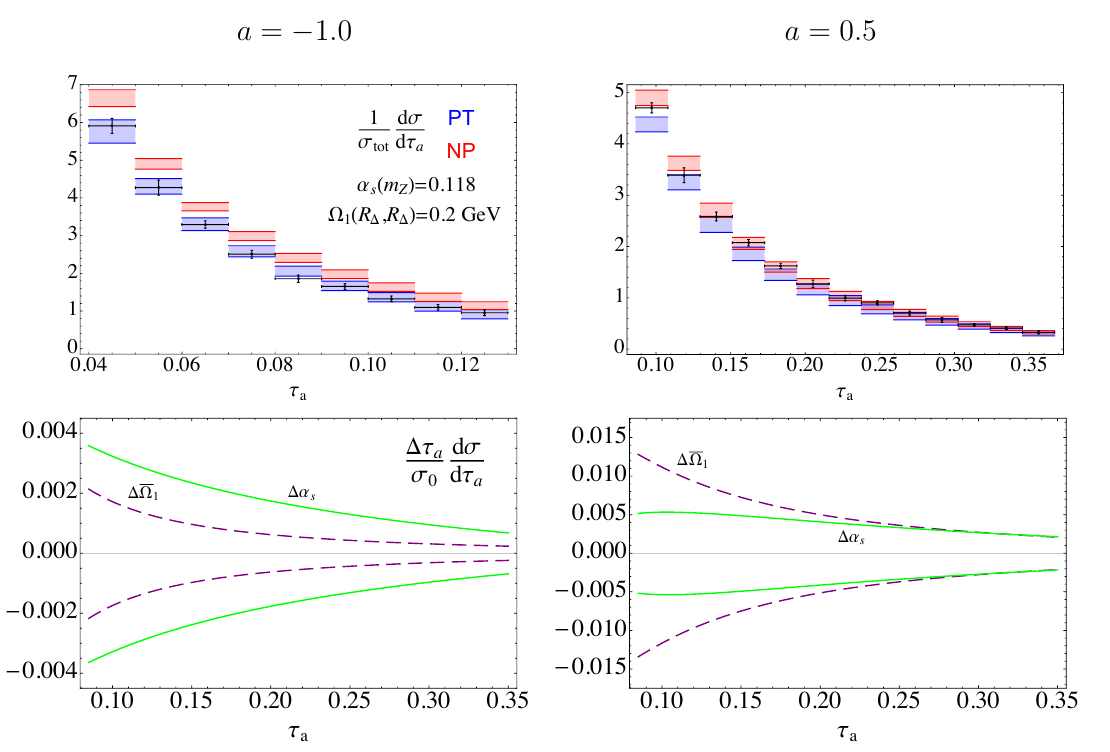
Figure 18 . Top : a binned data comparison at a = (cid:11) s ( m Z ) = 0 : 118 and (cid:10) 1 ( R (cid:1) ; R (cid:1) ) = 0 : 2 GeV. All other settings are the same as in (cid:12)gure 15. As is clear, the (cid:12)nal renormalon-corrected (red) curves overshoot the data at a = small shift parameter, successfully describe the a = 0 : 5 data. Bottom : di(cid:11)erence between central curves and curves evaluated with single variations of either (cid:10) 1 (dashed, purple) or (cid:11) s ( m Z ) (solid, green) at the same values of a and Q = m Z . Note that the lower plots are generated with canonical scales, are unmatched, and the variation about (cid:10) 1 is illustrated using the shift (1.3), rather than the fully shape and renormalon-corrected